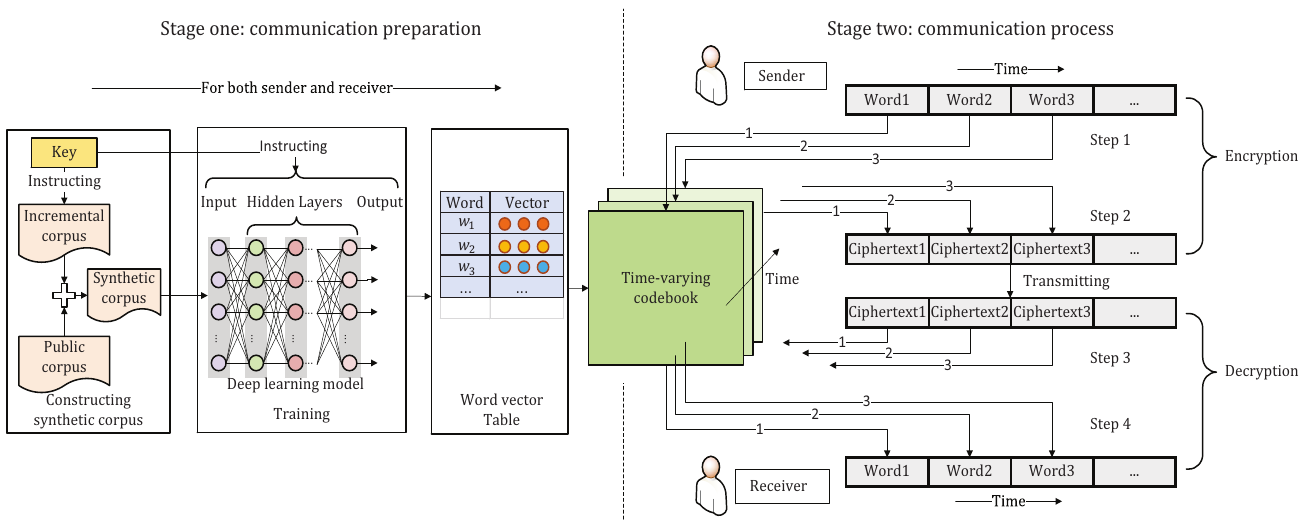
Figure 1. TEDL overview: a two-stage encryption